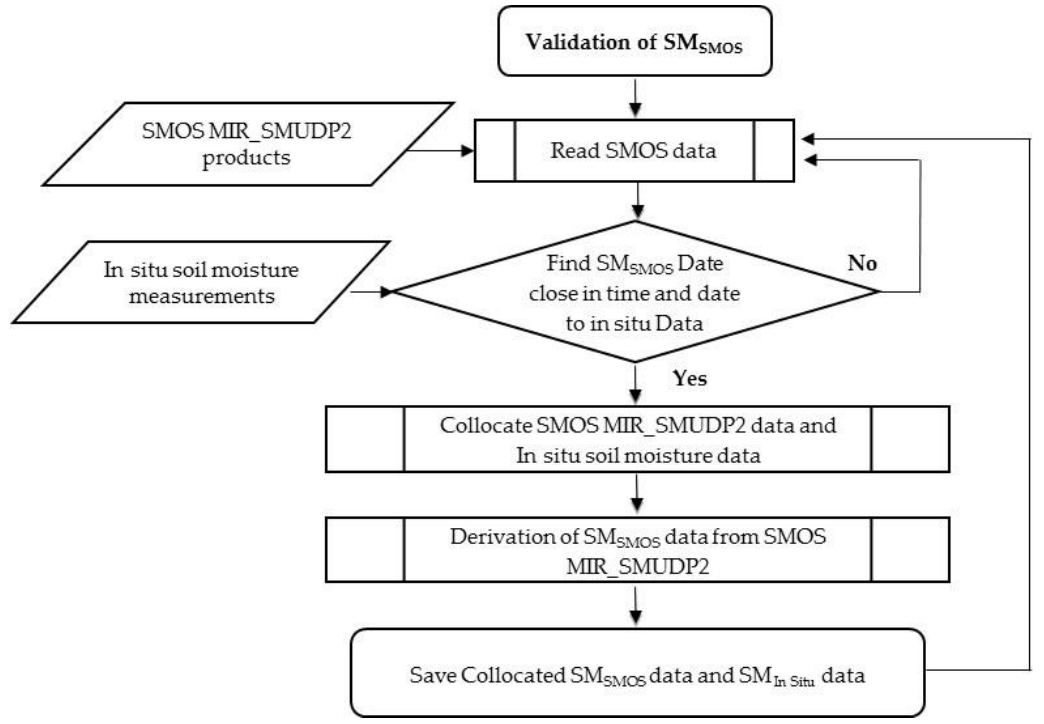
Figure 3. Flow chart of SM SMOS data validation algorithm.